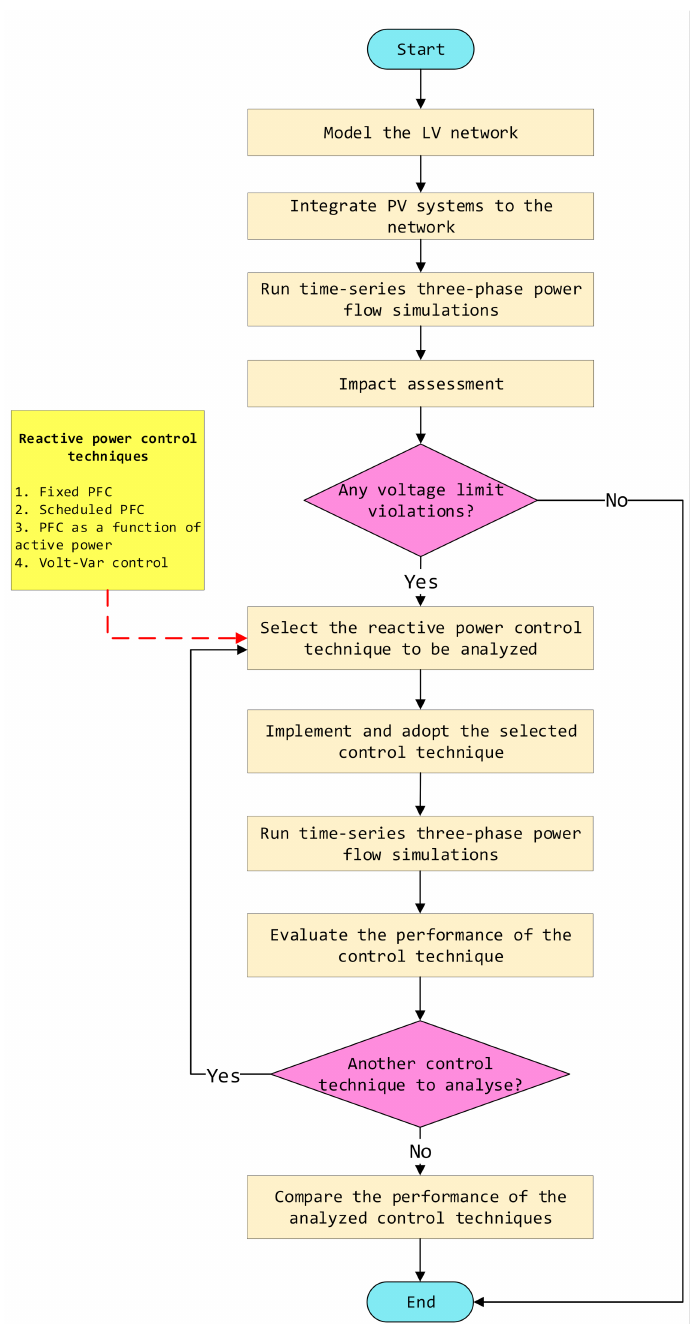
Figure 5. Flowchart of the research